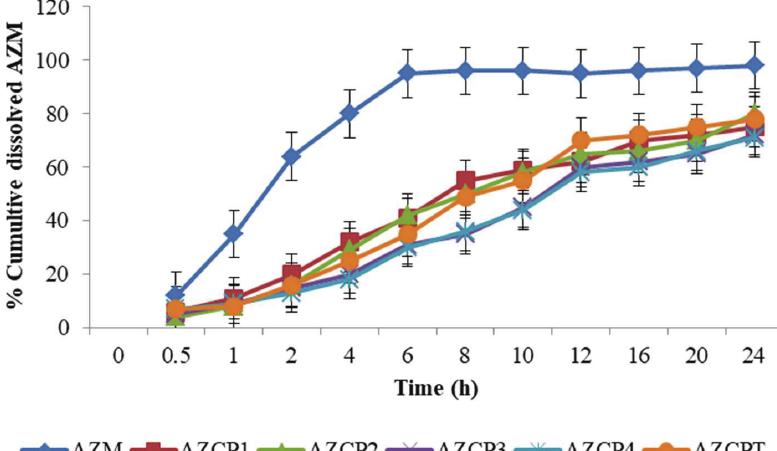
Fig. 5. Dissolution rate of AZM microparticles prepared from carnuba wax (values represent mean±SD, n =6)